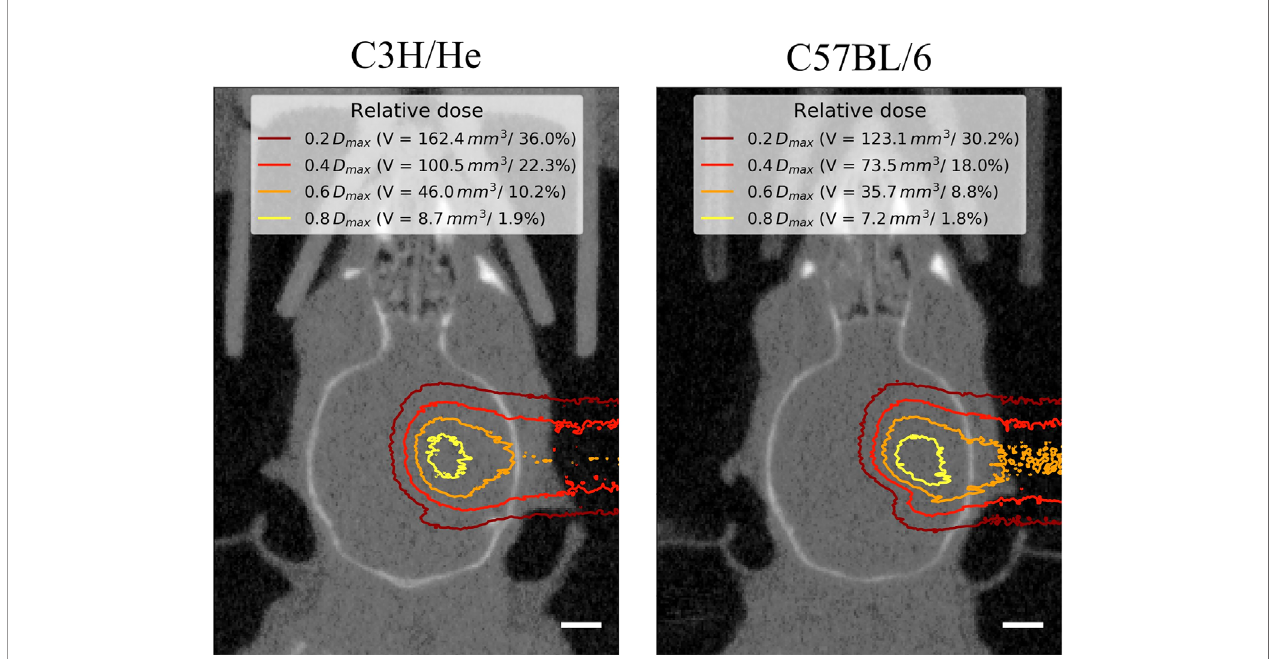
FIGURE 2 | Representative mouse brain CTs in treatment position for one C3H/He and one C57BL/6 mouse with dose distributions from Monte-Carlo beam transport simulations. Little dose was deposited within the contralateral hemisphere. The extent of the brain that received at least a certain fraction of the dose maximum D max is given as absolute volume V and as percentage of the brain volume. Scale bars 2